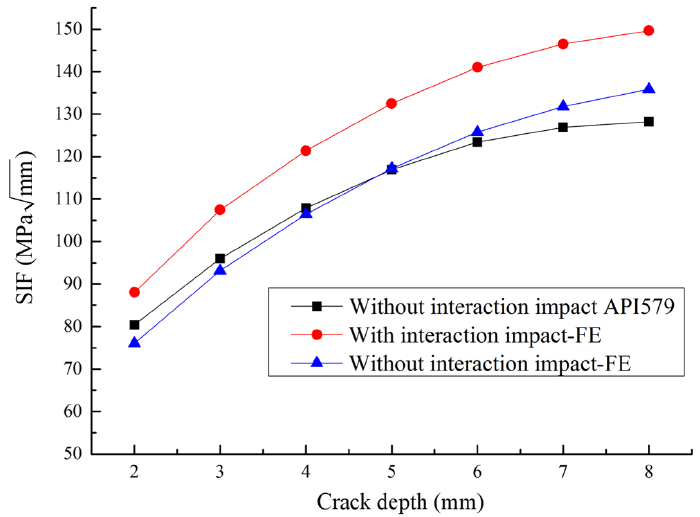
Figure 3. Comparison of pipeline SIF results.